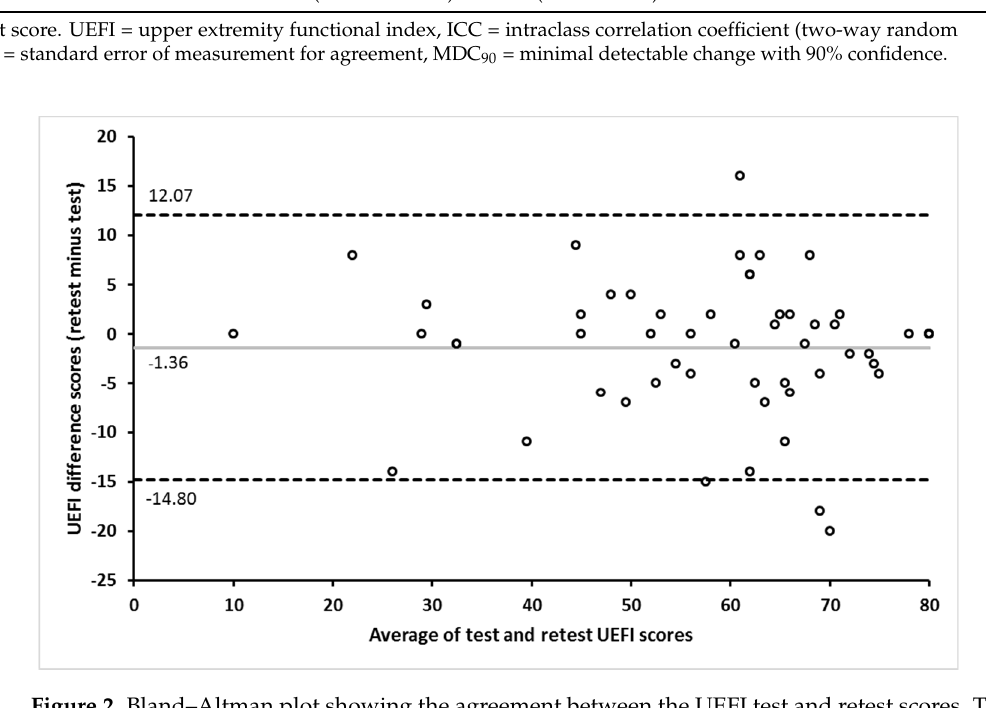
Table 3. Correlation between UEFI and other measures ( N = 70).